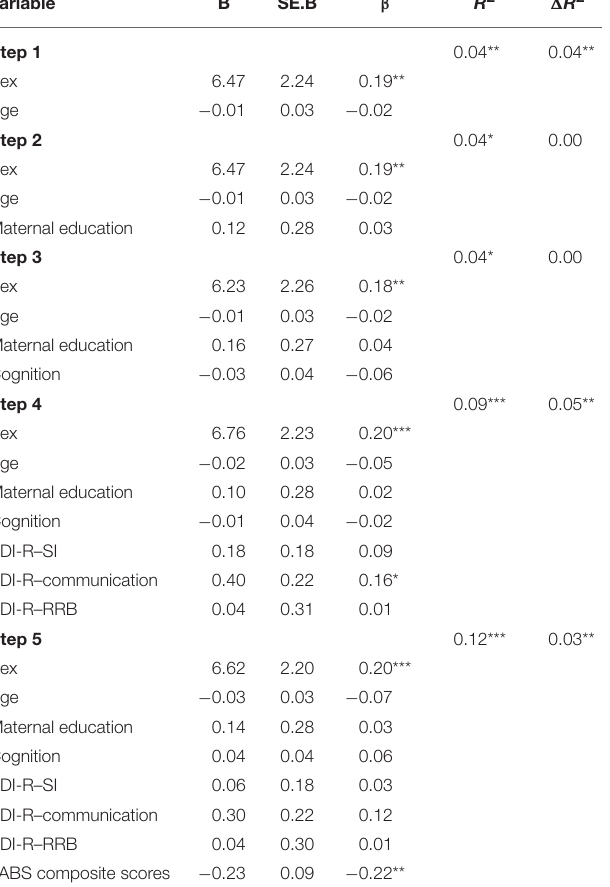
TABLE 6 | Linear regression model for the CPRS inattentive scores. Variable